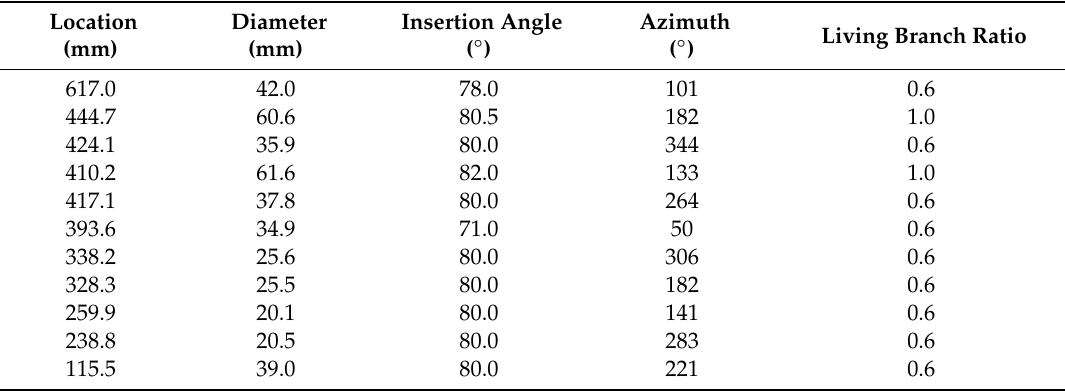
Table 1. Measured information of the first log